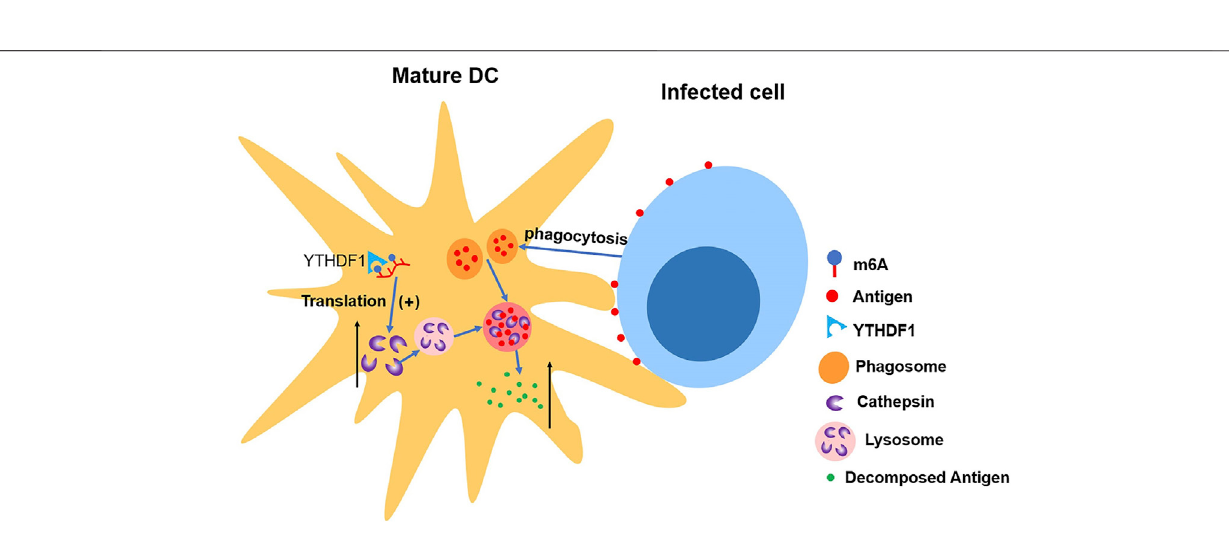
Frontiers in Cell and Developmental Biology |